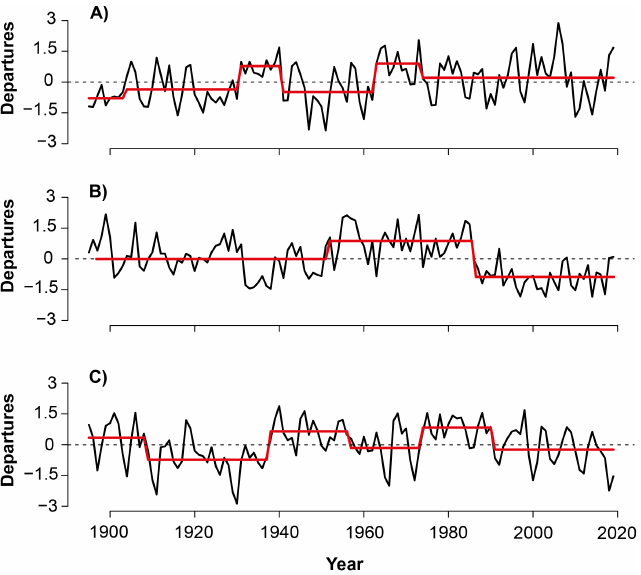
Figure 5. Amplitudes of the principal components PC1 ( A ), PC2 ( B ), and PC3 ( C ) based on the correlation matrix of the standardized chronologies of Nothofagus spp. (black lines) for the common period 1895–2019. The red horizontal lines show the regime shifts in the PCs using the detection method